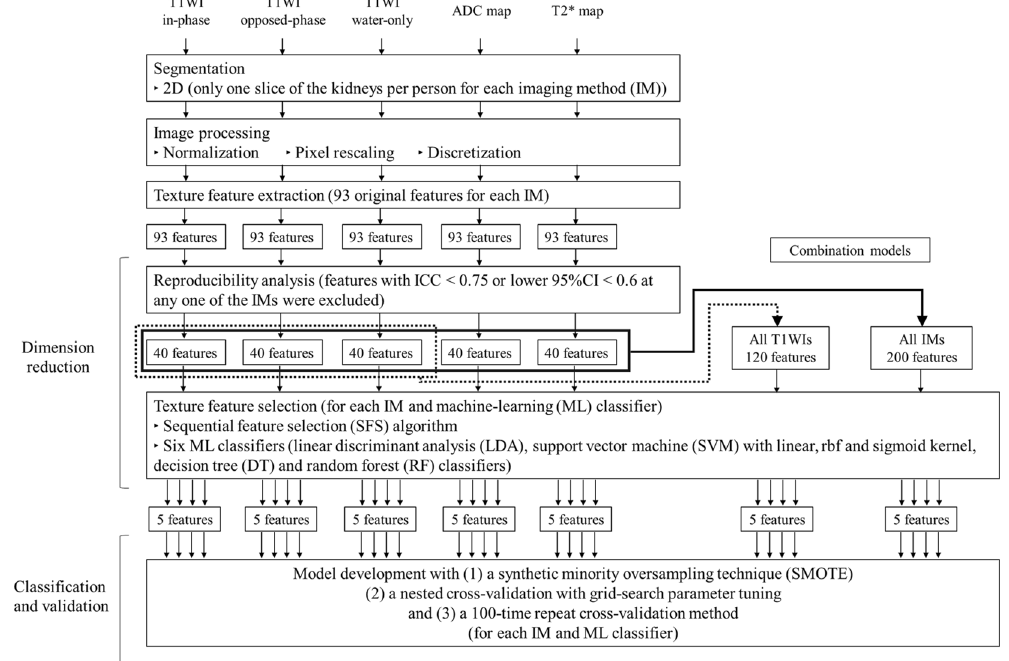
Figure 4. Flow chart showing the technical study pipeline. After segmentation, image processing, texture feature extraction, and reproducibility analysis were conducted for each imaging method (T1-weighted in-phase/opposed-phase/water-only images, ADC maps, and T2* maps), followed by texture feature selection and ML-based model construction in separate classification attempts. The combinations of texture features were also examined: those derived from all T1-weighted images and those derived from all imaging methods.